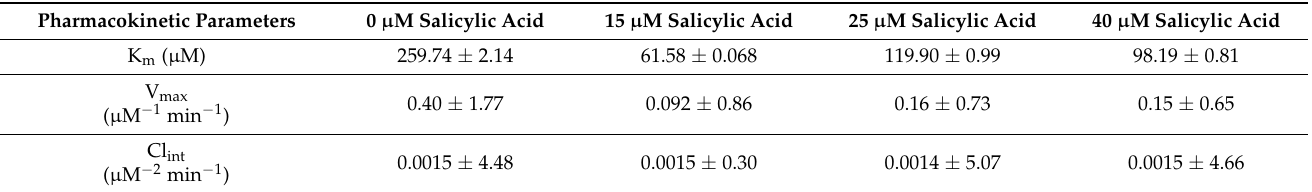
Figure 3. Representative Lineweaver–Burk plot for the inhibition of UGT2B17-catalysed testosterone glucuronide (testos- terone (25–200 μ M)) with 0, 15, 25, and 40 μ M salicylic acid ( n = 3). Table 12. Pharmacokinetic parameters of UGT2B17 inhibition study. Values are noted as mean ± σ (n = 3) ( p = 0.001) at α =